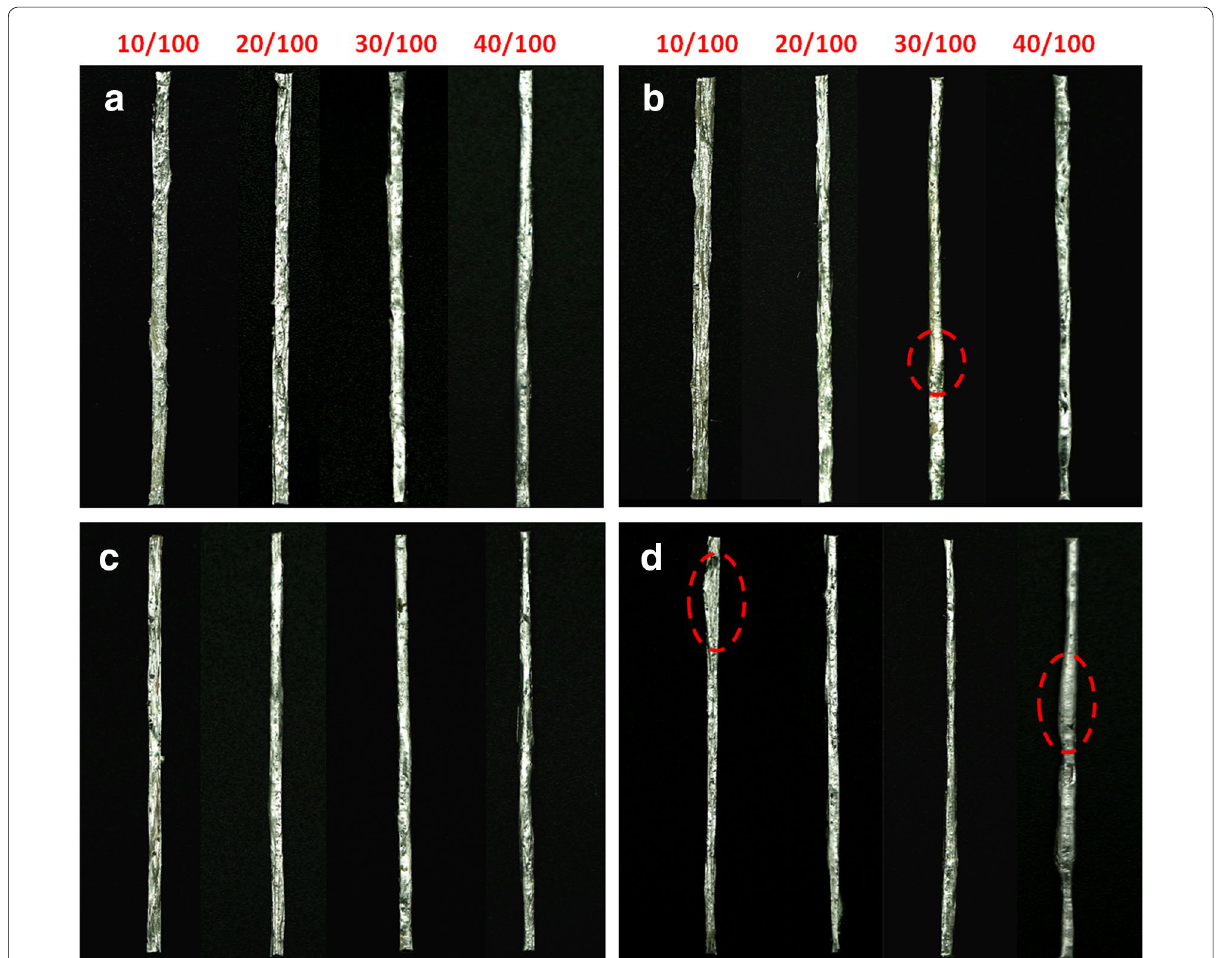
Figure 3 Monofilament morphology of specimens at the printing velocity of ( a ) 1 mm/s, ( b ) 2 mm/s, ( c ) 3 mm/s, and ( d ) 4 mm/s and wire feeding of 10/100, 20/100, 30/100,